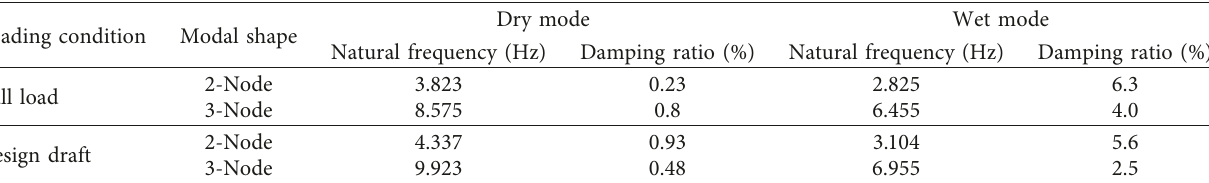
Figure 9: Vertical acceleration RAOs for vertical bending (VB) excitation. (a) Full load condition in air. (b) Design draft loading condition in air. (c) Full load condition in water. (d) Design draft loading condition in water. Table 3: Vertical bending modal results from measurement.